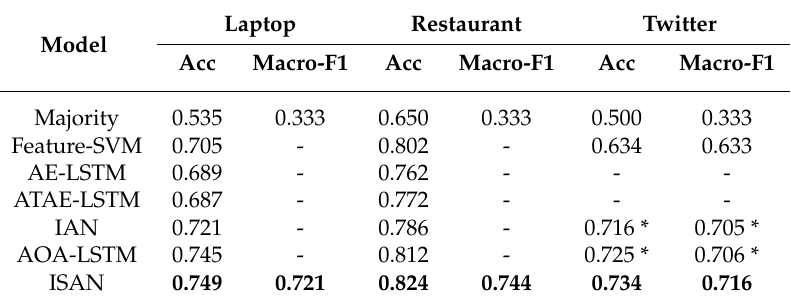
Table 2. Performance comparison of different models on the three datasets. The baseline models results are accessed from published papers except for the ones marked with “*”. The values in bold represent the highest performance values. Laptop Model